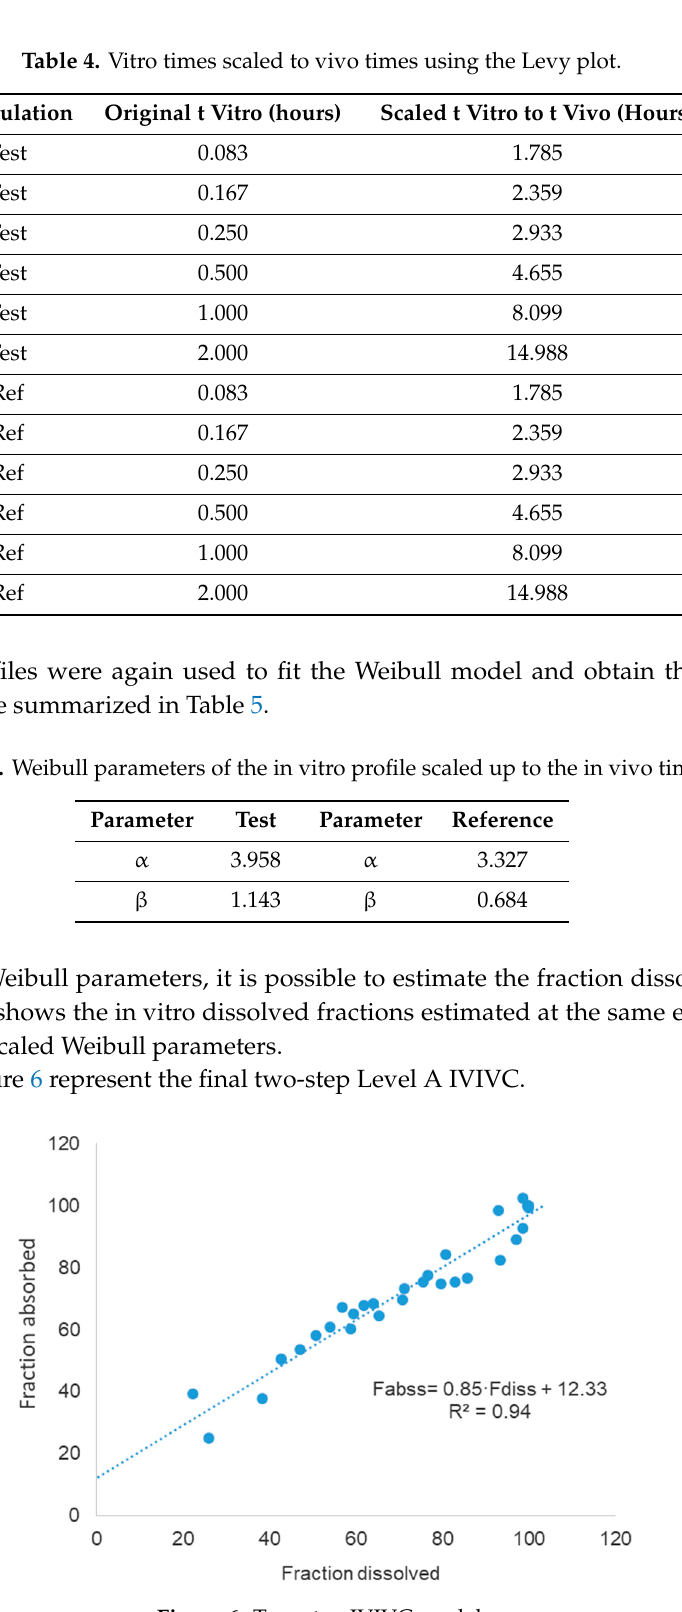
Figure 6. Two-step IVIVC model.